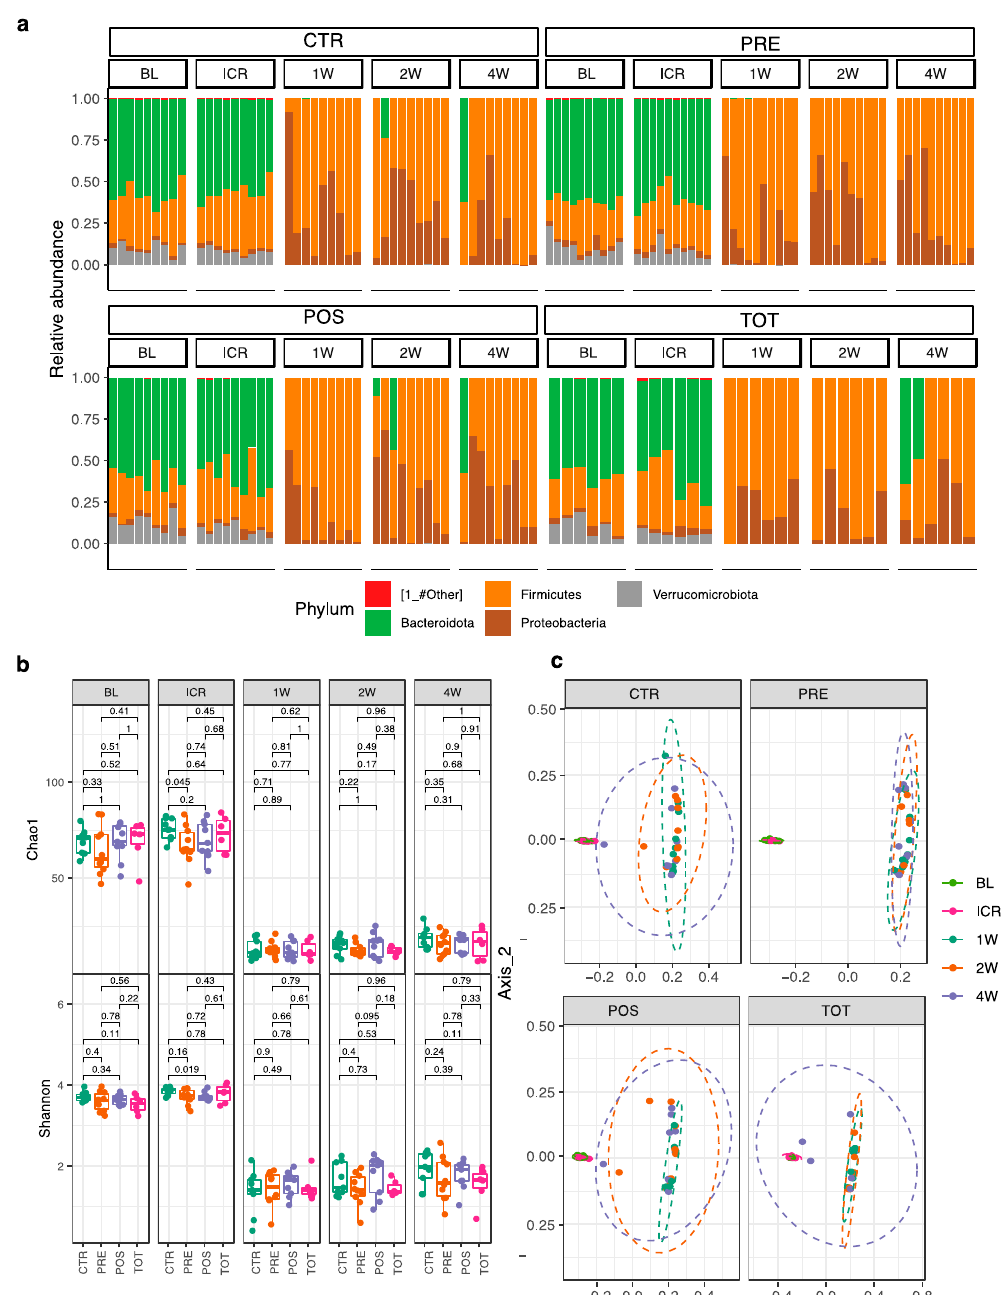
Figure 2. Difference in microbial abundance at the phylum level along changes in alpha and beta diversity from BL to W4. ( a ) Phylum ‐ level differences in relative microbial abundance between groups over time. ( b ) Within ‐ and between ‐ group changes in α ‐ diversity using Chao1 and Shannon indices. ( c ) Between ‐ group differences from baseline to week 4 in β‐ diversity using weighted UniFrac analysis.